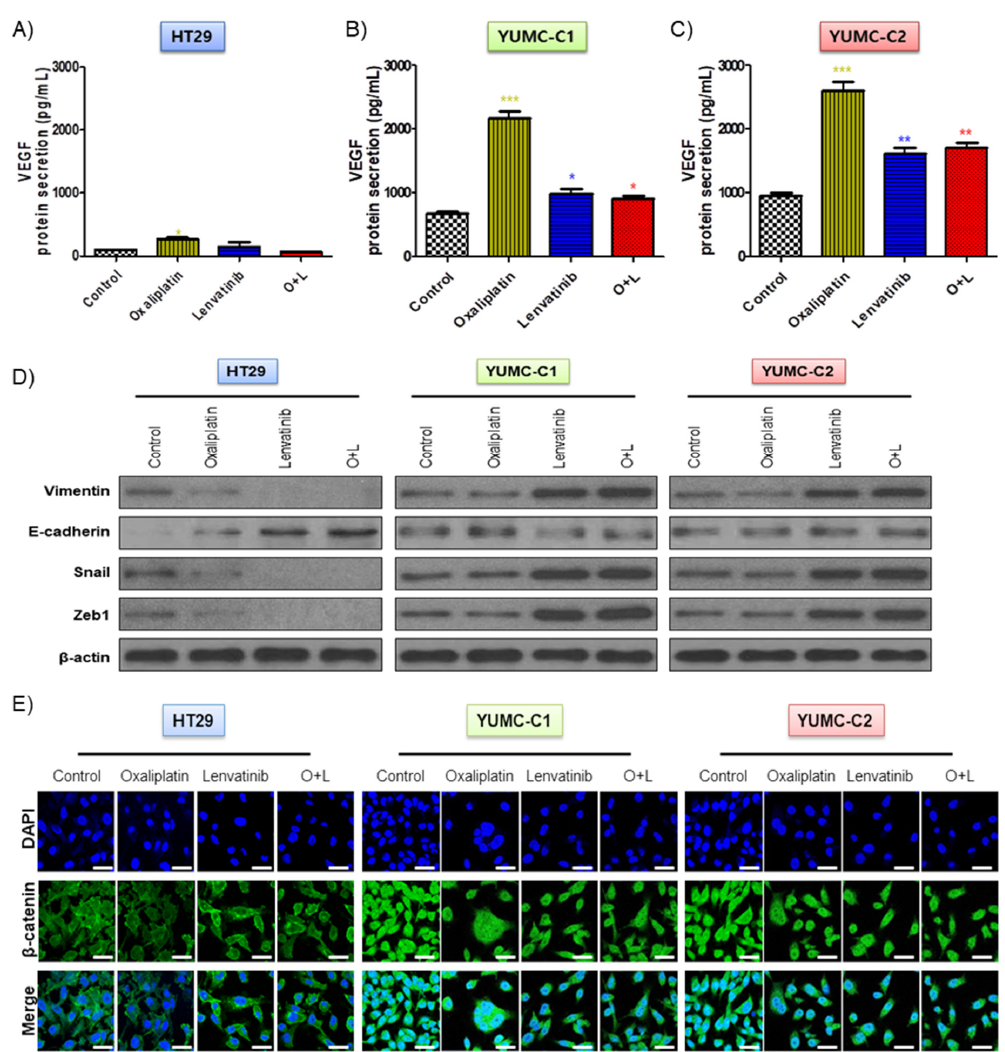
Figure 3. ( A–C ) Enzyme-linked immunosorbent assay (ELISA) of secreted vascular epithelial growth factor (VEGF) expression in conditioned media of HT-29, YUMC-C1, and YUMC-C2. ( D ) Immunoblot analysis and. ( E ) Examined at 400× magnification; scale bar, 20 μ m, immunofluorescence cytochemical staining about β -catenin, markers of EMT in HT-29, YUMC-C1, and YUMC-C2 cells. VEGF secretion and EMT expression were suppressed to a greater extent in HT-29 cells than in YUMC-C1 and YUMC-C2 cells. All experiments were repeated at least three times. Data are the means ± SD. * p < 0.05, ** p < 0.01, and *** p < 0.005 compared with the control.